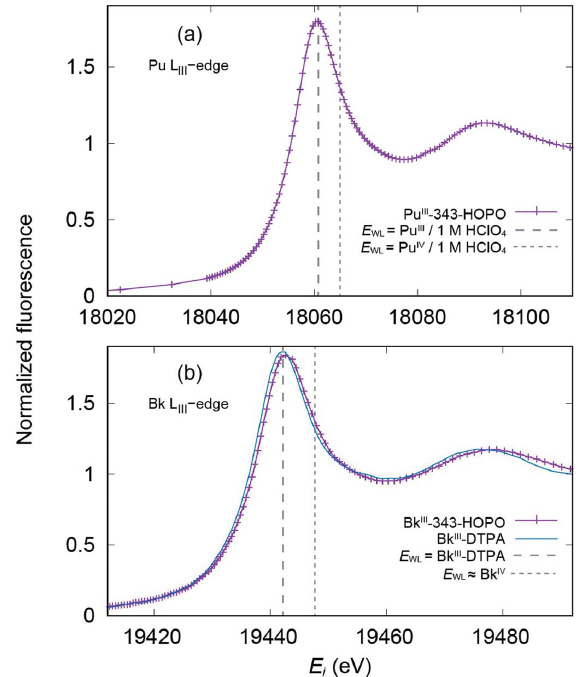
Figure 2 L III -edge XANES spectra collected on frozen solutions of ( a ) Pu(III)- 343-HOPO and ( b ) Bk(III)-343-HOPO (purple traces). The vertical dashed lines in ( a ) highlight the white-line position ( E WL ) for oxidation- state references Pu(III) and Pu(IV) in 1 M HClO 4 solutions (Conradson et al. , 2004), which have been calibrated to the Zr K -edge (Kraft et al. , 1996). The XANES data for Bk(III)-DTPA (blue trace) is plotted in ( b ) for comparison, along with the Bk(III)-DTPA E WL position (vertical dashed line). In addition, an estimated E WL position of a hypothetical Bk(IV)-DTPA complex (vertical dashed line) is shown as a Bk(IV) oxidation state reference. The estimate of the Bk(IV)-DTPA E WL was calculated as a +5.5 eV shift from the Bk(III)-DTPA white line as was observed in the electrochemical oxidation of Bk(III) to Bk(IV) in 1 M